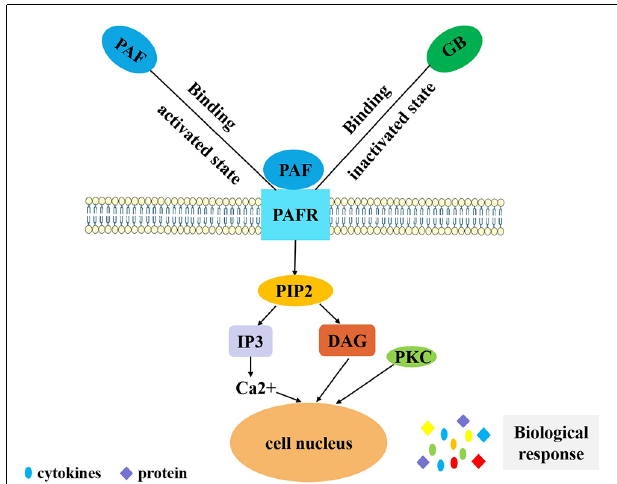
FIGURE 2 | PAF-mediated signal transduction of ginkgolides in the regulation of IIR. PAF binds to PAF receptor in vivo , and coupled with G protein, phospholipase C is activated and has an effect on phosphatidylinositol 4,5-bisphosphate. Phosphatidylinositol bisphosphate breakdown produces inositol triphosphate and diglyceride. Inositol triphosphate can induce intracellular calcium concentration increases and diglyceride can activate PKC. Finally, it exerts a biological effect by secreting cytokines and proteins. GB competitively inhibits PAF binding to PAFR in order to reduce the above series of reactions and play an anti-inflammatory role. PAF, platelet-activating factor; IIR, inflammatory immune response; PKC, protein kinase C; GB, ginkgolide B.PAF, platelet-activating factor; PAFR, platelet-activating factor receptor; GB, ginkgolide B; PIP2, phosphatidylinositol 4,5-bisphosphate; IP3, inositol 1,4,5-triphosphate; DAG, diacylglycerol; PKC, protein kinase C; IIR, inflammatory immune